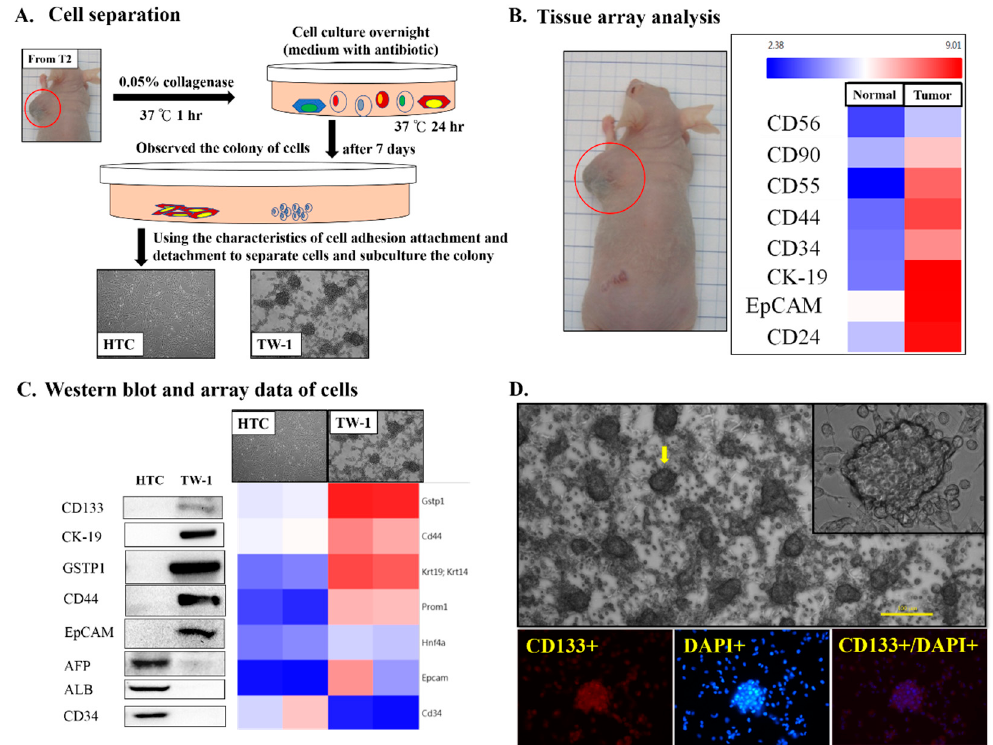
Figure 1. Establishment of the HTC and TW-1 cell lines. ( A ) Schematic design of the isolation of two different cell lines from T2-xenografted nude mouse. ( B ) Microarray analysis of T2-derived tumor tissue sample. The normal sample was from the adjacent non-malignant tissue. ( C ) Western blotting and microarray analyses of the HTC and TW-1 cells. ( D ) Cell morphology and immunofluorescence staining of the TW-1 cells.